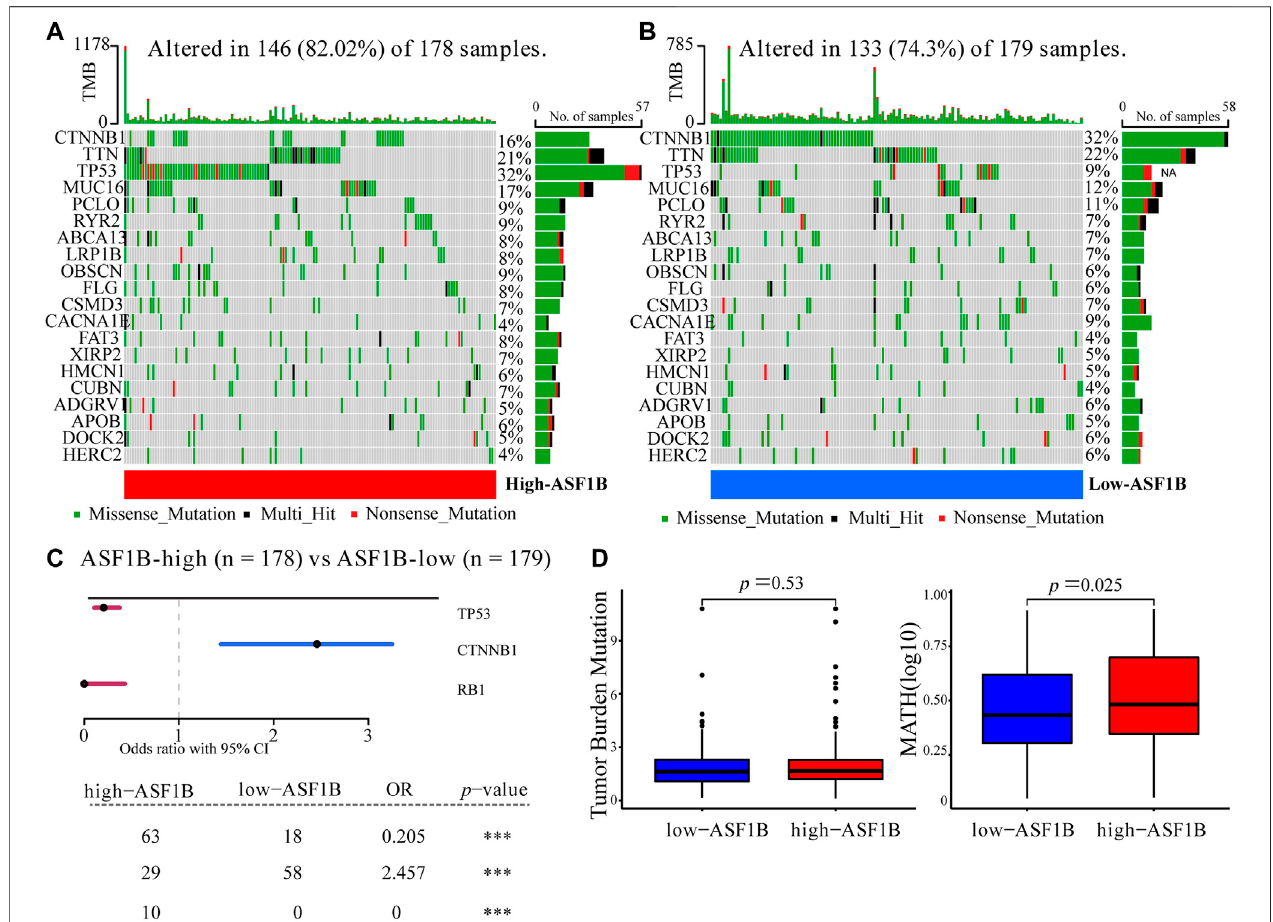
FIGURE6| SomaticmutationbetweenASF1B-highandASF1B-lowexpressiongroup.Oncoplotsdisplayedthetop-20mutatedgenesinthe (A) high-ASF1Band (B) low-ASF1BgroupoftheTCGA-LIHCdataset. (C) Forestplotrevealedthreemutatedgeneswithstatisticsigni fi cantbetweentheASF1B-highandASF1B-lowgroup. (D) The comparison of TMB (left) and MATH (right) scores in the ASF1B-high and ASF1B-low group. *** p <